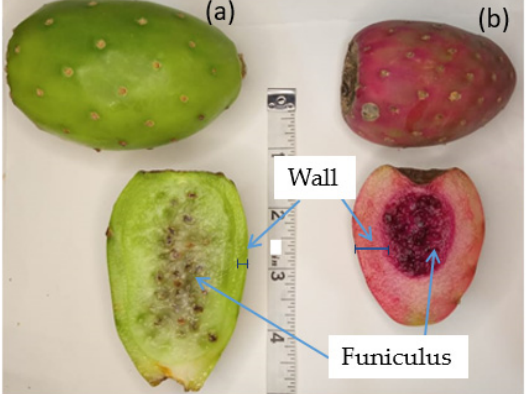
Figure 1. Distinctive characteristics between prickly pear cactus fruit ( a ) and xoconostle ( b